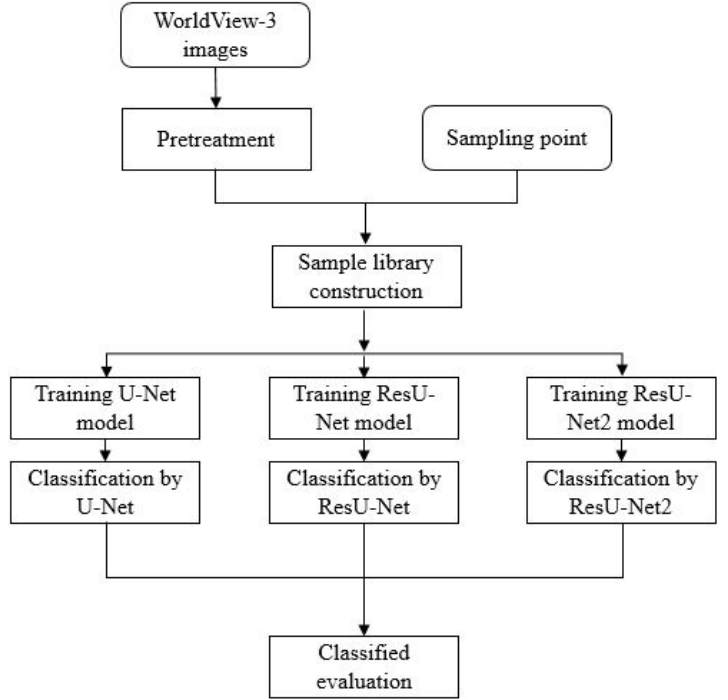
Figure 3. Flow chart of the experimental